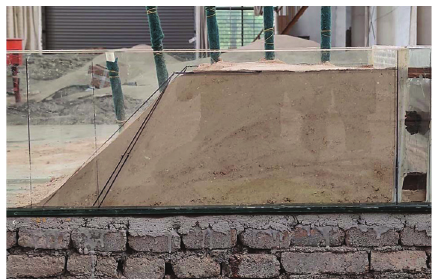
Figure 2: The small-scale rare earth pile under a horizontal liquid injection.